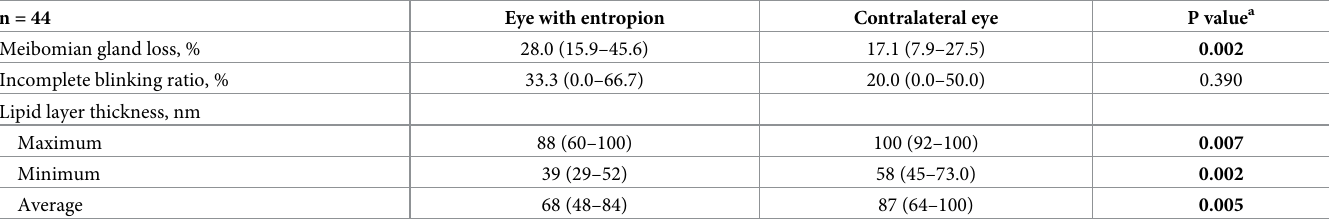
Table 2. Comparisons of meibographic and interferometric results between eyes with unilateral marginal entropion and contralateral normal eyes. n = 44